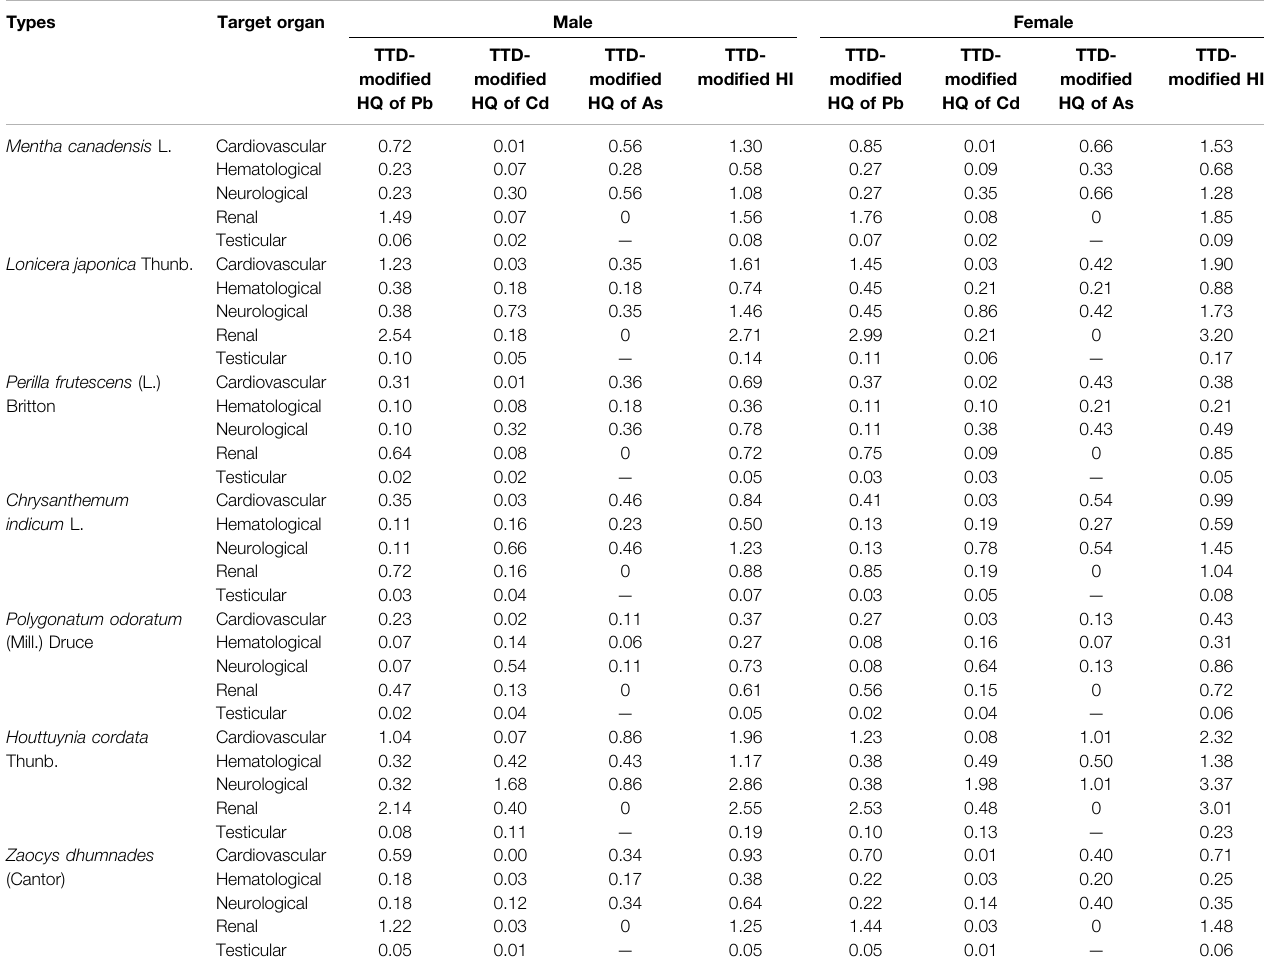
TABLE 5 | Precise cumulative risk assessment results of MFSV used as food based on TTD modi fi cation of the HI method.